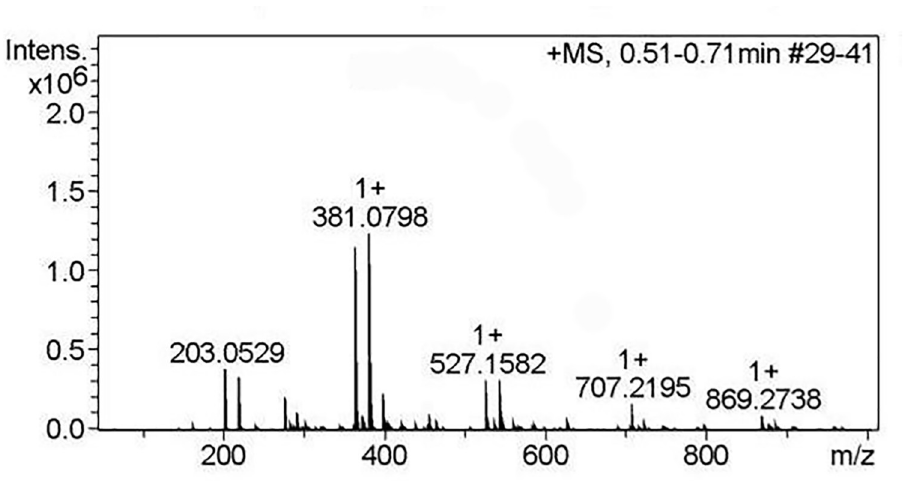
Fig 6. LC-MS spectra of the oligosaccharides synthesized by AglB with melibiose as substrate.